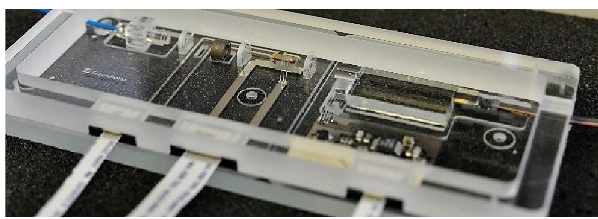
Fig. 2: Glass-based electro-optical micro-bench for optical spec- trum analysis including micro-optics (filters, isolators, lenses), assembled by sequential active alignment with temporary fixing of components using integrated vacuum-channels, and metalliza- tion (solderable, and wire-bondable) to include electro-optical and electronic features (EOM, TIA, PIC).